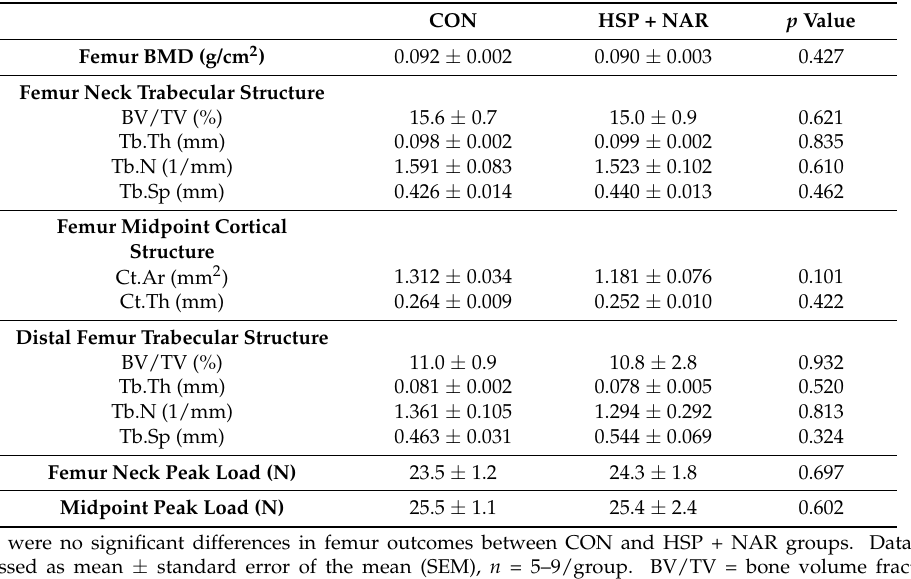
Table 2. Ex vivo bone mineral density (BMD), structure and peak load of the femur in 6-month-old female mice whose mothers were exposed to control (CON) or 0.5% hesperidin (HSP) + 0.25% naringin (NAR) diets through pregnancy and lactation.